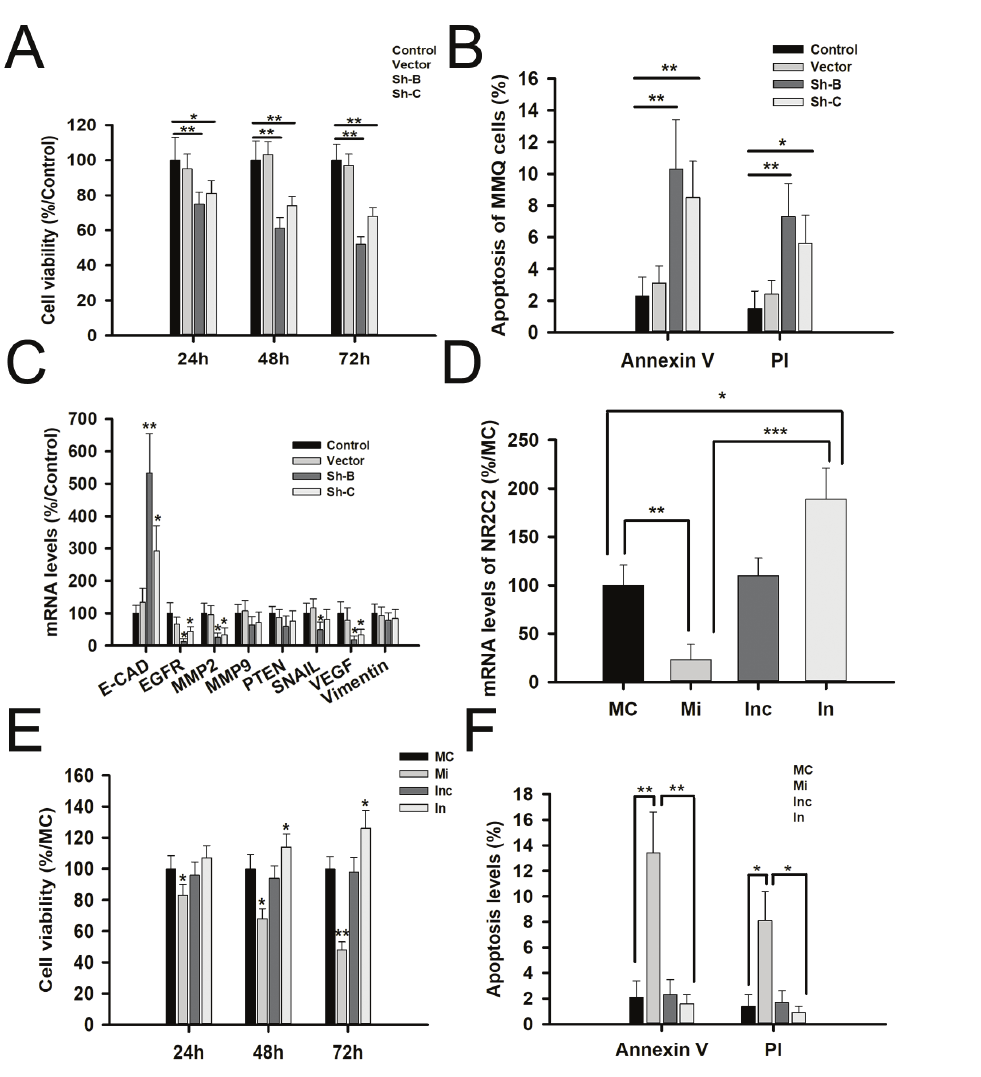
Figure 4: NR2C2 and miR-129-5p regulated the cell proliferation through inducing the apoptosis of MMQ cells. A: MTS experiment showed knockdown of NR2C2 suppressed the cell viability of MMQ cells. B: Knockdown of NR2C2 increased the apoptosis levels of MMQ cells. C: Knockdown of NR2C2 affected the mRNA levels of genes related with EMT in MMQ cells. D: miR-129-5p mimic downreguted the mRNA levels of NR2C2 in MMQ cells. E: MTS experiment showed miR-129-5p mimic inhibited the cell proliferation of MMQ cells. F: miR-129-5p mimic increased the apoptosis levels of MMQ cells.